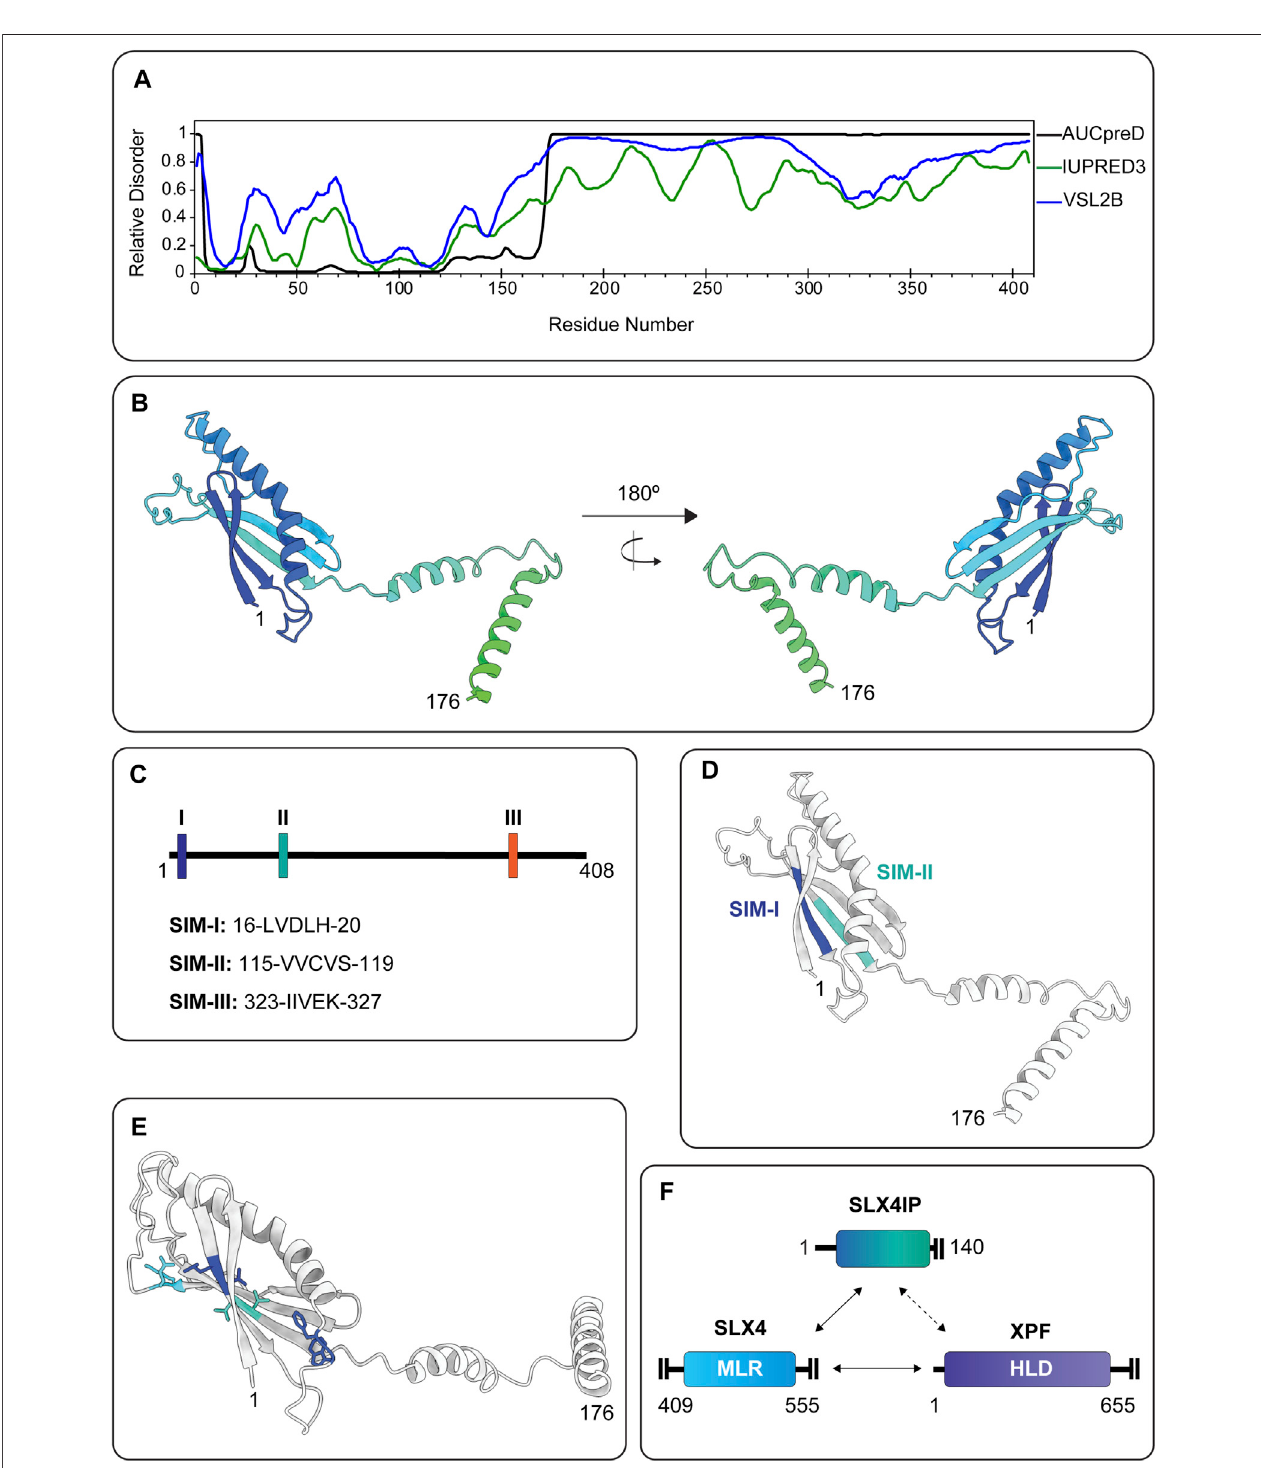
FIGURE 8 | (A) Disorder probability plots for human SLX4IP using the AUCpreD (black trace) (Wang et al., 2016), IUPRED3 (green trace) (Erdos et al., 2021) and VSL2B (blue trace) (Peng et al., 2006) predictors. The N-terminus of SLX4IP is predicted to be relatively ordered whereas the C-terminus is predicted to be largely disordered,asindicatedbyadisordertendency score > 0.5. (B) PredictedstructuralarchitectureoftheSLX4IP N-terminus(residues1 – 176)showninrainbow colorand generated byAlphaFold(Jumper et al., 2021). (C) Linear representation ofSLX4IP showing theapproximate locations ofthree putative SIMs, designated asSIM-I, SIM-IIandSIM-IIIandpredictedusingGPS-SUMO(Renetal.,2009;Zhaoetal.,2014).Theaminoacidsequenceofeachmotifisshownbelowtheschematic.Numbers represent the fi rst and last residue in the motifs. (D) Predicted structure of the SLX4IP N-terminus (residues 1 – 176), as generated by AlphaFold (Jumper et al., 2021).